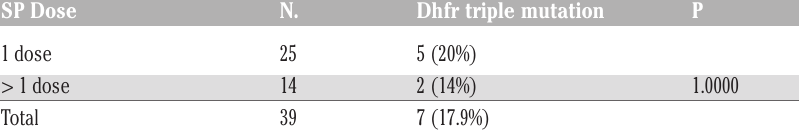
Table 3. The effect of number of doses of SP on the presence of triple dhfr mutation. SP Dose